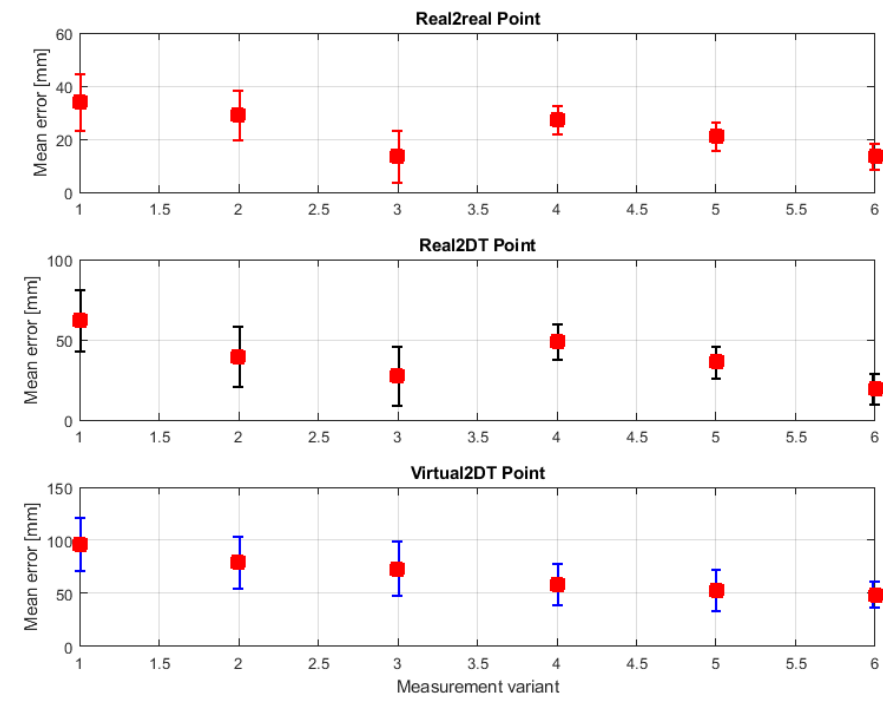
Figure 16. Mean error and its standard deviation for different measurement